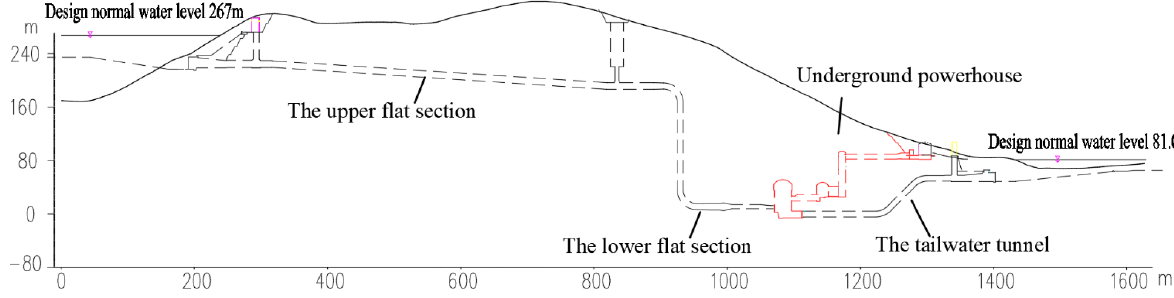
Figure 2. Water convey